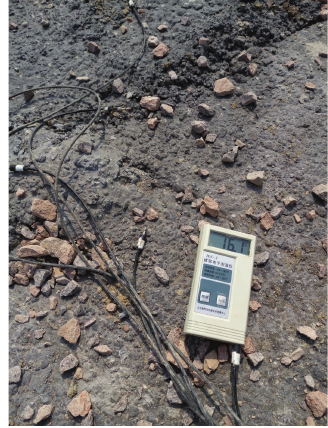
Figure 8: Temperature rise procedure test